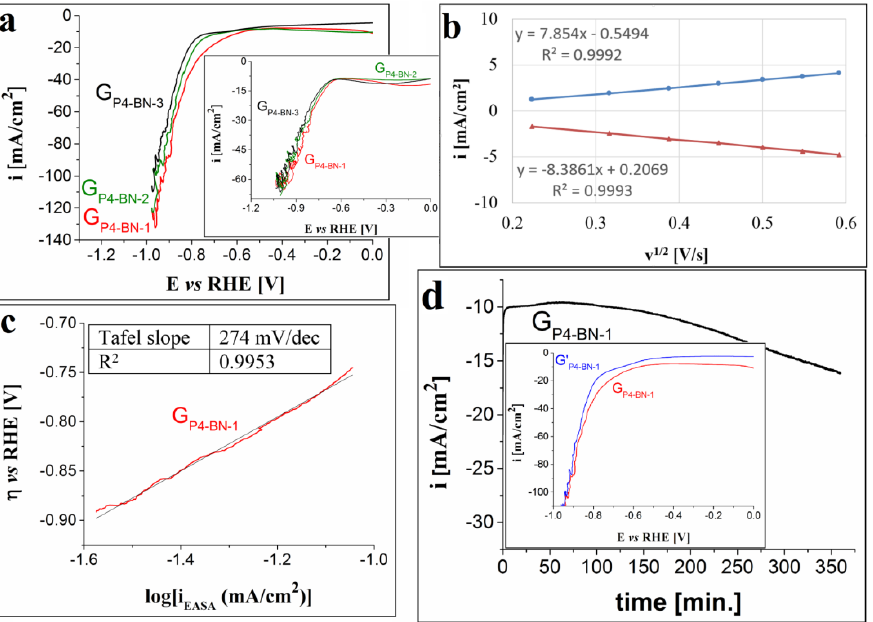
Figure 9. ( a ) Cathodic LSVs recorded on the G P4-BN-1 , G P4-BN-2 and G P4-BN-3 electrodes in 1 M KOH